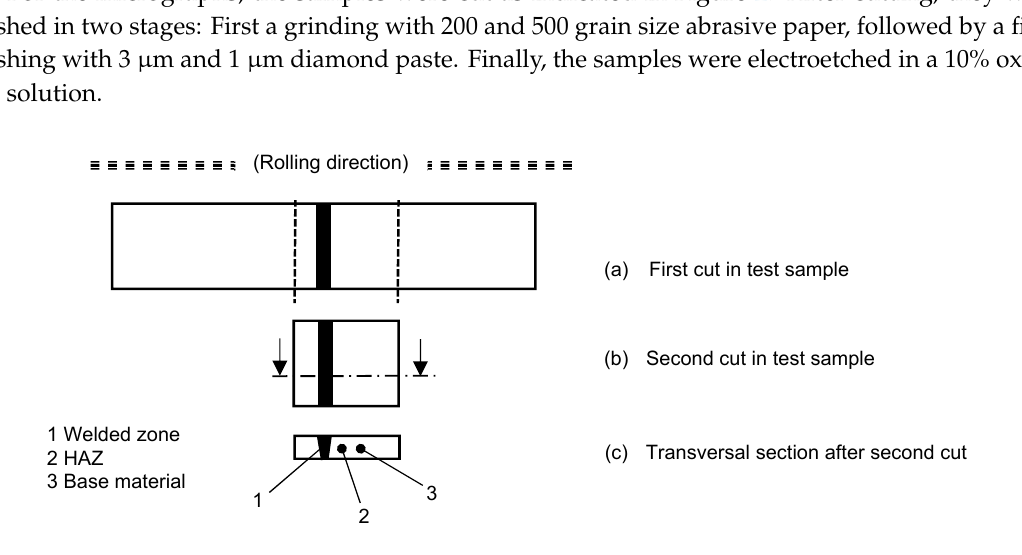
Figure 2. Samples preparation for micrographs and hardness measurement. The dashed triple line represents the rolling direction.